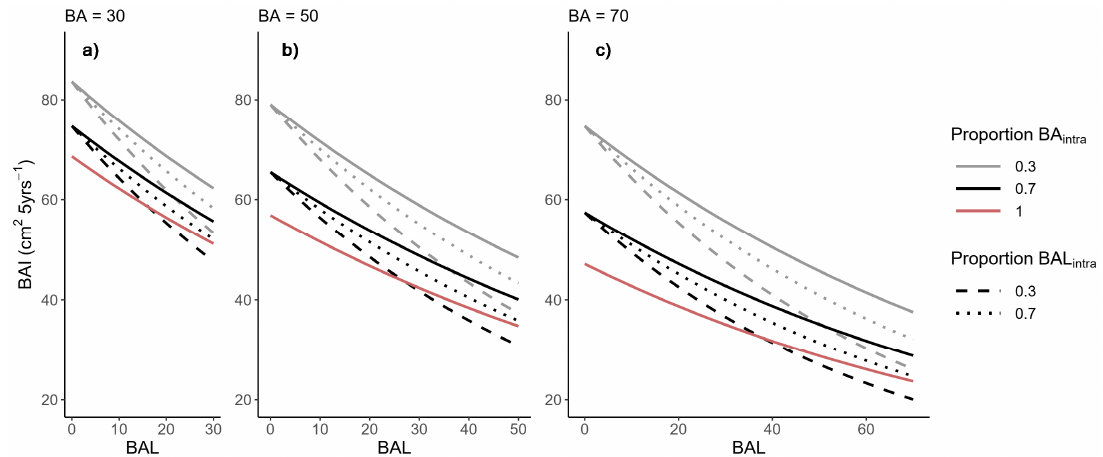
Figure 4. Variation of individual-tree basal area increment (cm 2 5 years −1 ) across the range in initial diameter for Maritime pine with: ( a ) increasing proportion of intraspecific size-symmetric competition (Proportion BA intra = BA intra /BA, = 0.2, 0.5, 0.8, or 1.0) for a stand with BA = 50 m 2 ha −1 , BAL intra = 10 m 2 ha −1 , and BAL inter = 0; and ( b ) increasing proportion of intraspecific size-asymmetric competition (Proportion BAL intra = BAL intra /BAL, = 0.2, 0.5, 0.8, or 1.0) for a stand with BA intra = 30 m 2 ha −1 and BAL = 30 m 2 ha −1 , and CR fixed at its mean value (CR = 0.35).